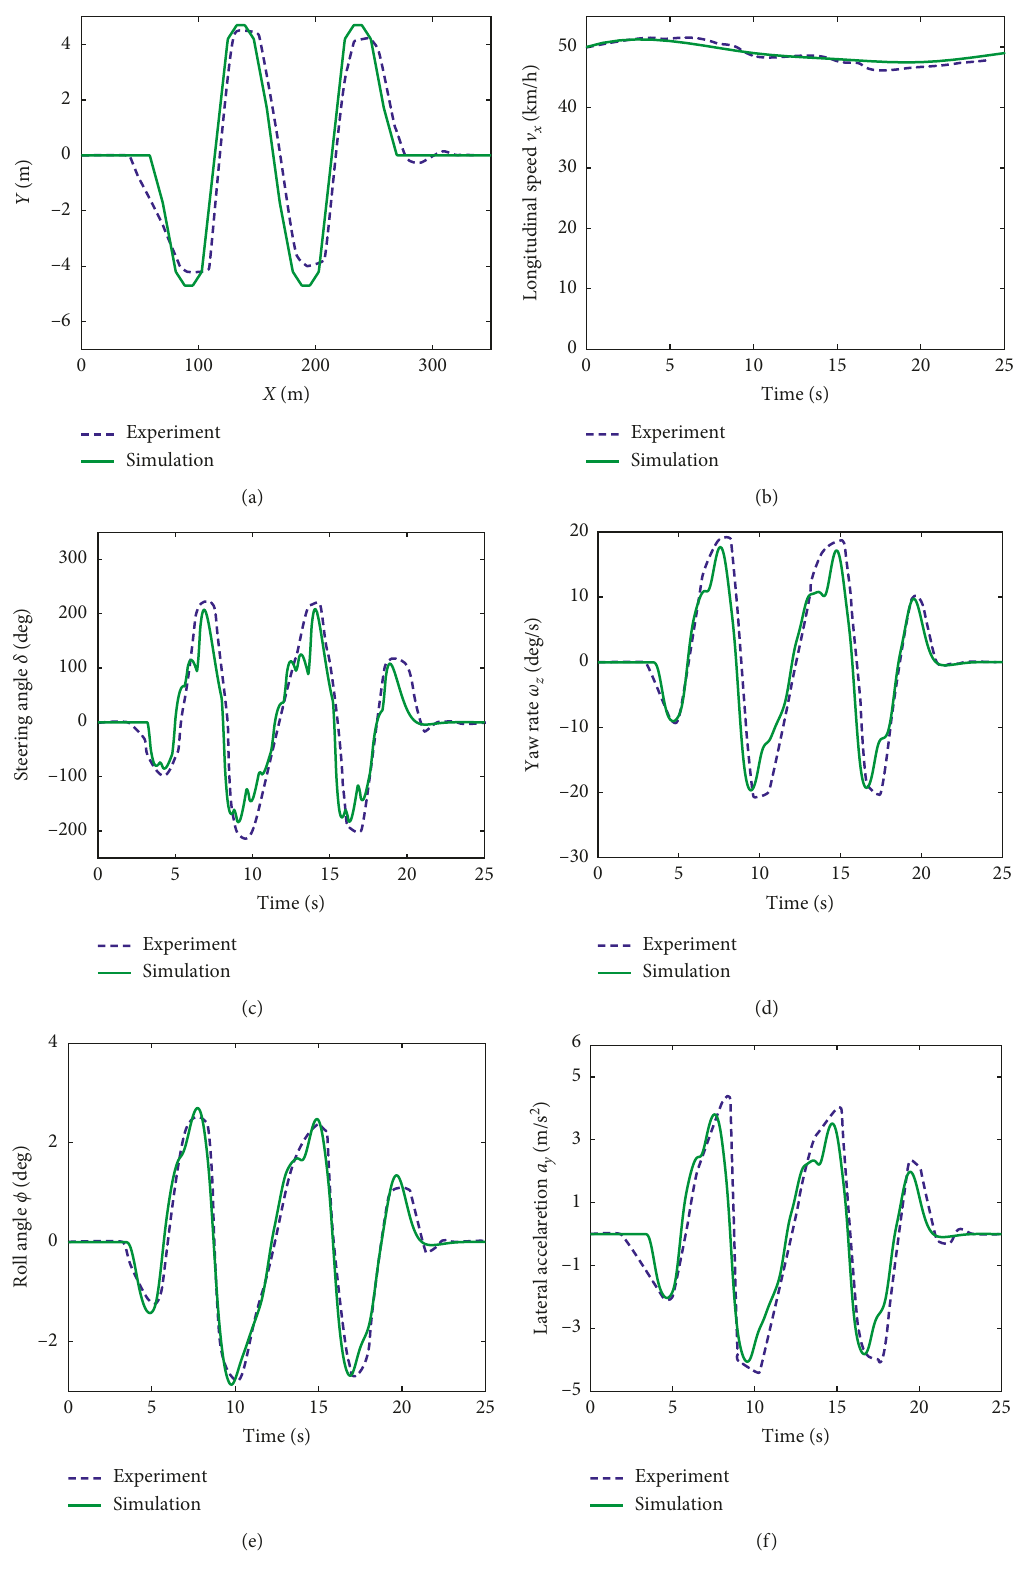
Figure 14: Snake condition results: (a) trajectory; (b) longitudinal velocity; (c) steering wheel angle; (d) yaw rate; (e) roll angle; (f) lateral